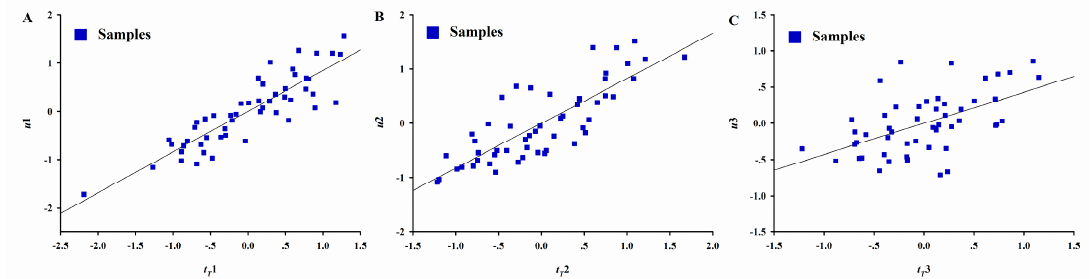
Figure 8. The relationships between the score of supermatrix T and that of matrix Y under the latent variables space of the MBPLSPM. ( A ) t T 1 vs. u1 ; ( B ) t T 2 vs. u2 ; ( C ) t T 3 vs. u3 .